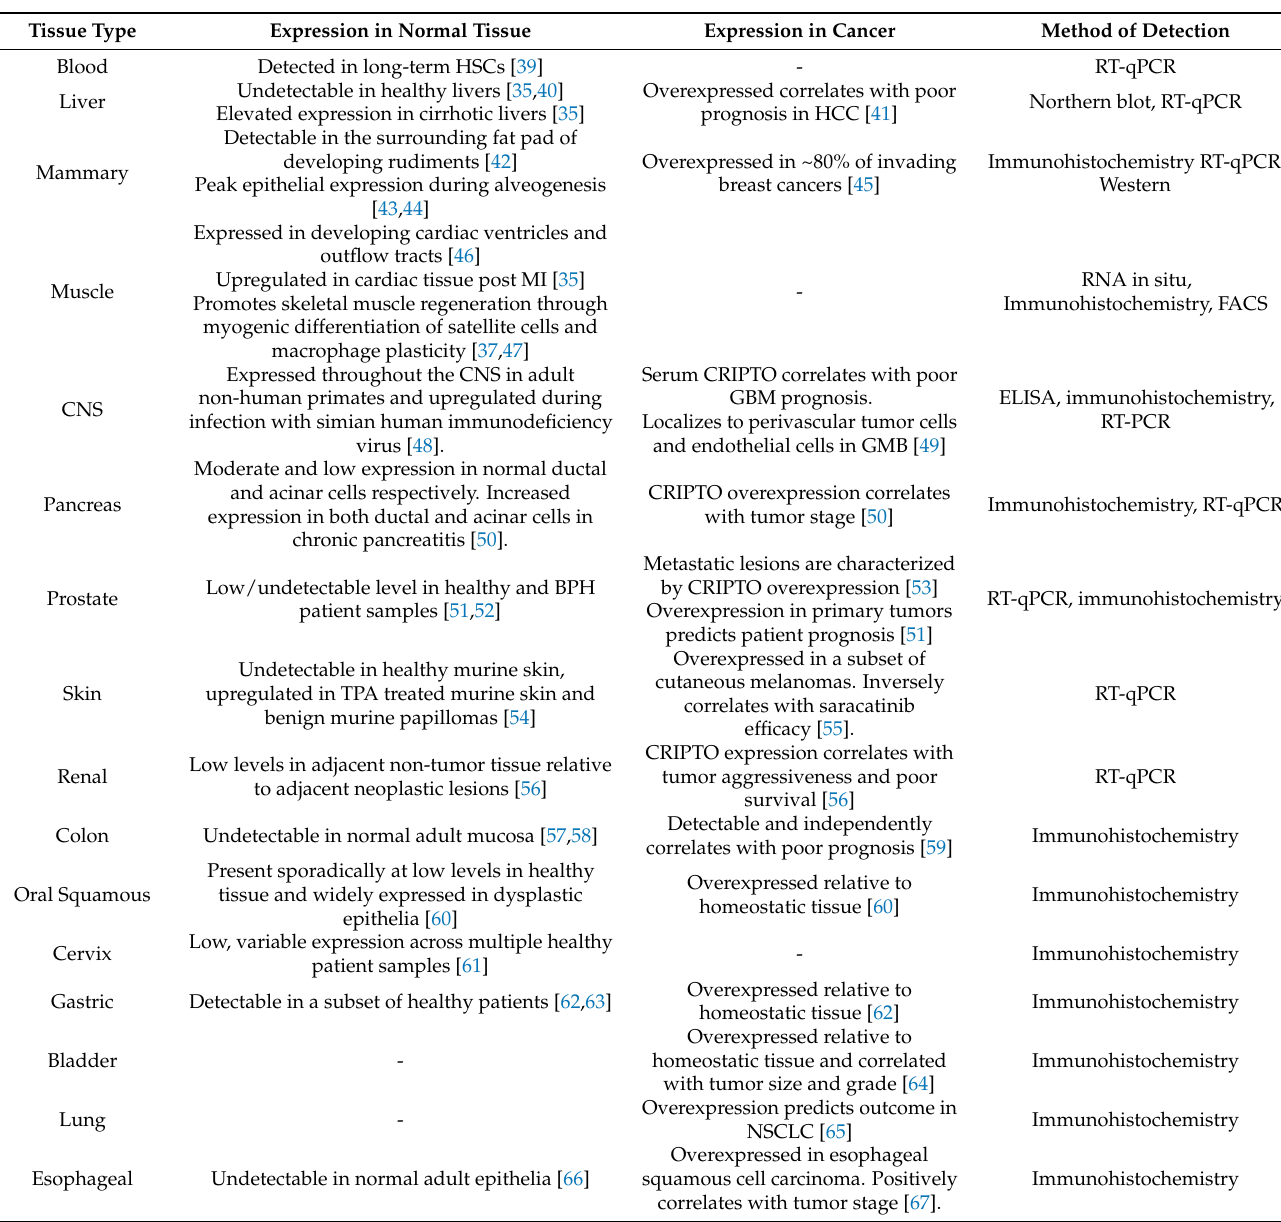
Table 1. CRIPTO detection in normal and cancerous